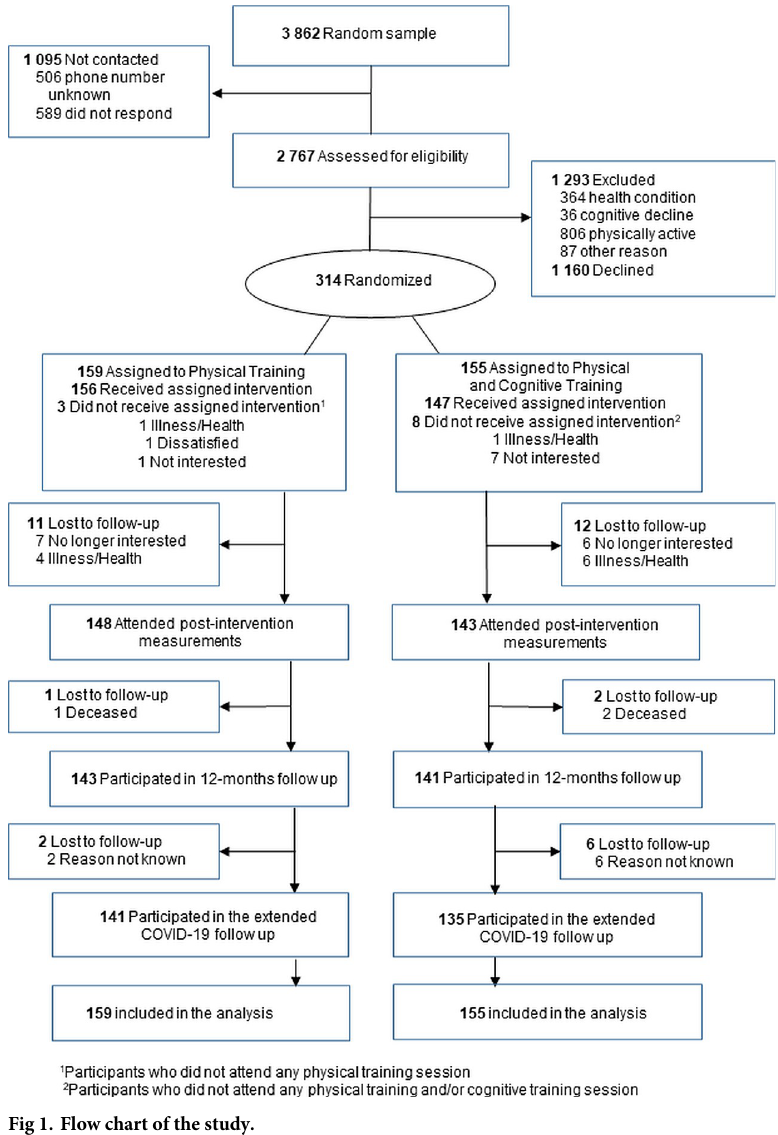
Fig 1. Flow chart of the